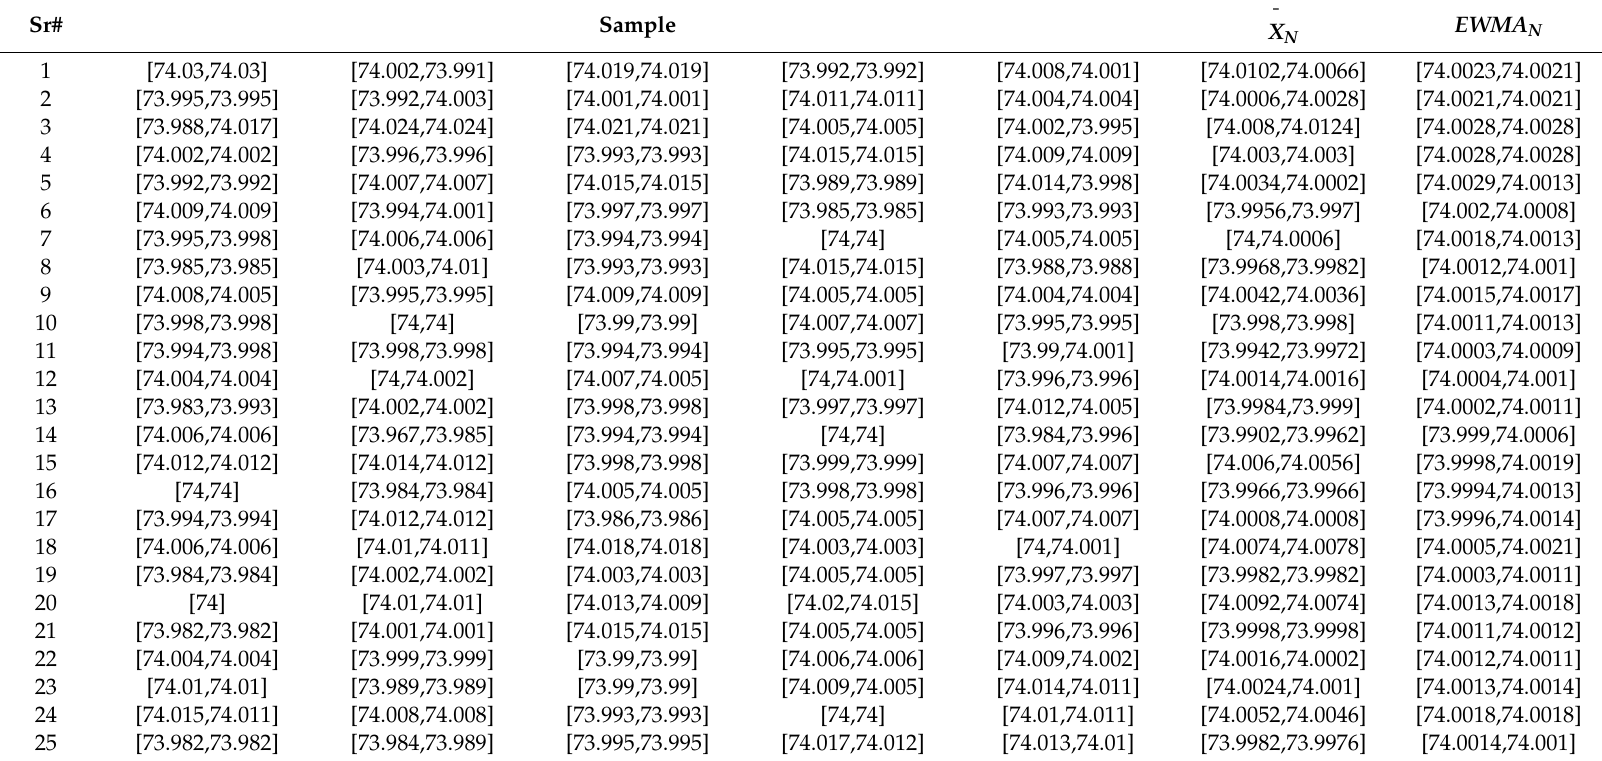
Table 7. The neutrosophic EPR